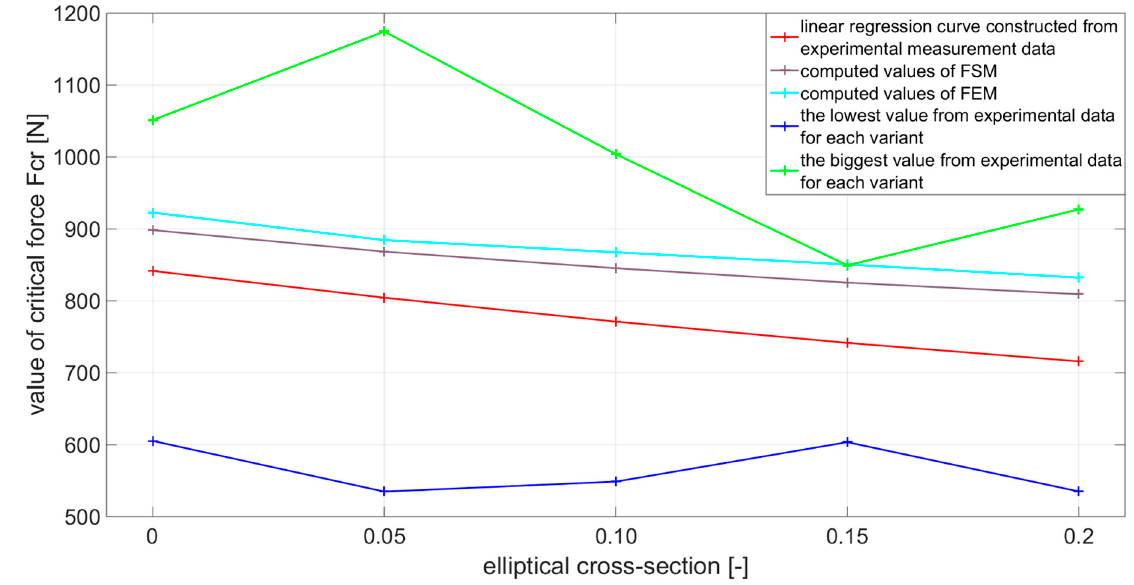
Figure 18. Plotted individual levels of critical force based on Table 8.